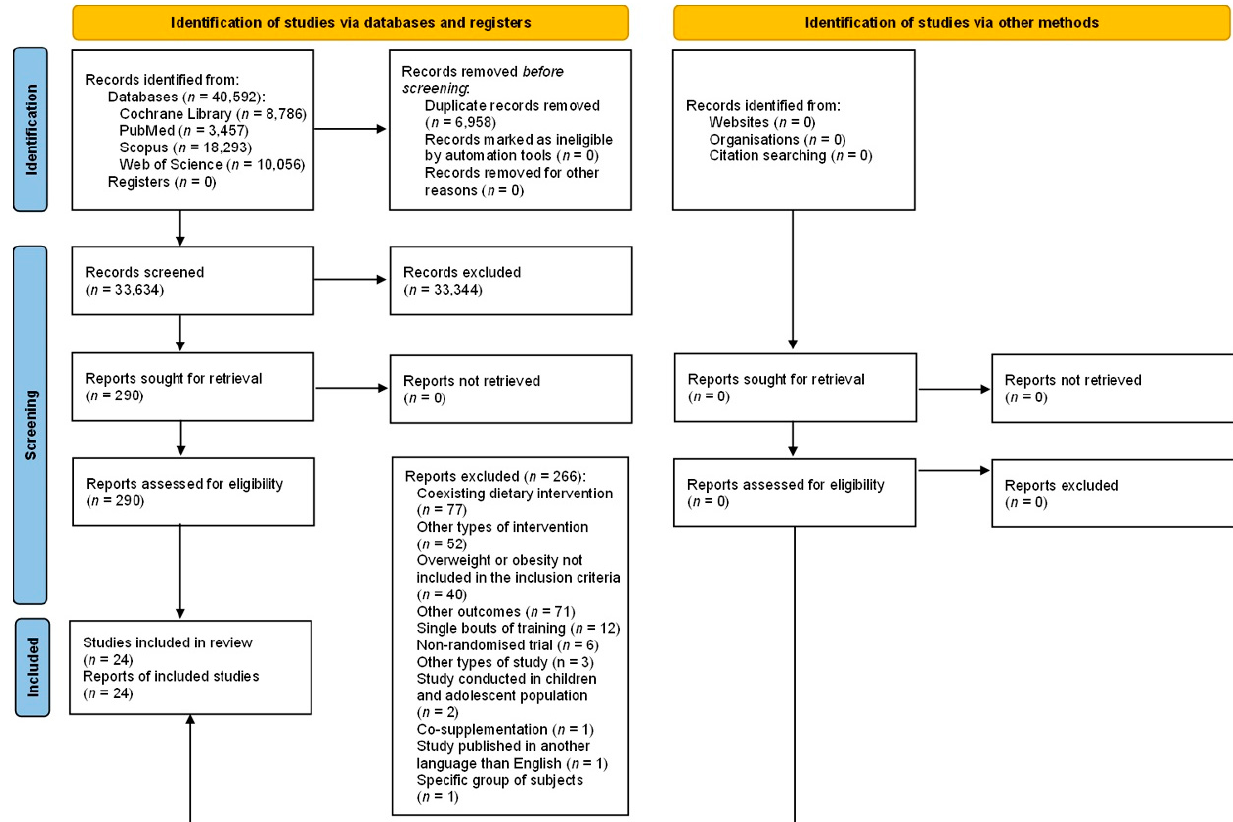
Figure 1. PRISMA 2020 flow diagram.